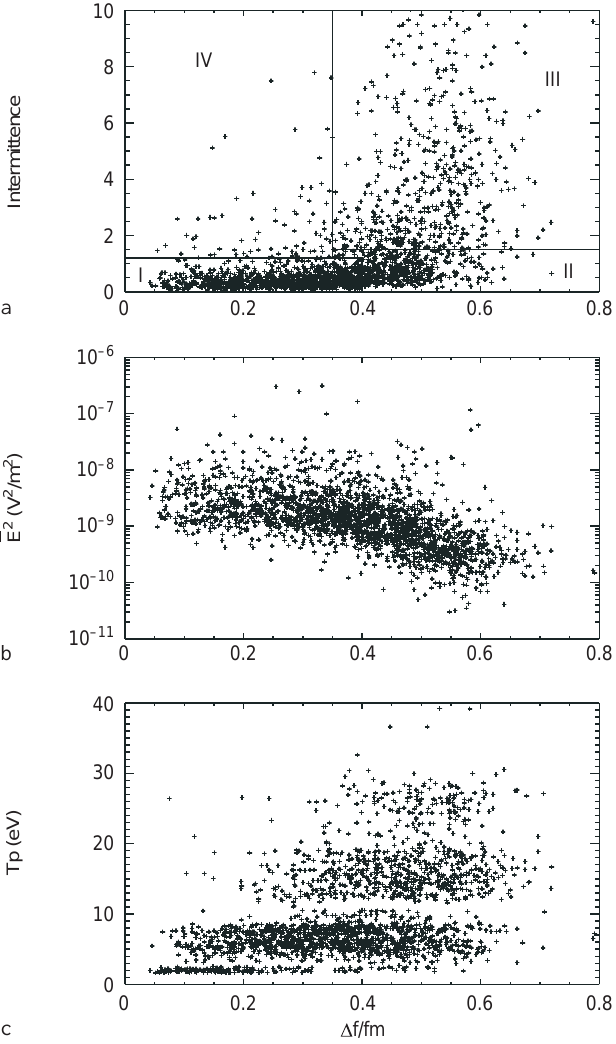
Fig. 2a. Scatter plot of the intermittence I (Eq. 4) versus the relative band width, for all the LF events observed with the highest sampling rate. LF wave packets are found in region I, and isolated electrostatic structures in region III. b Scatter plot of the energy density, in V 2 /m 2 , versus the relative band width for the events of a . c scatter plot of the solar wind proton temperature T p in eV, at the time of the e.s. events of a versus the relative band width of